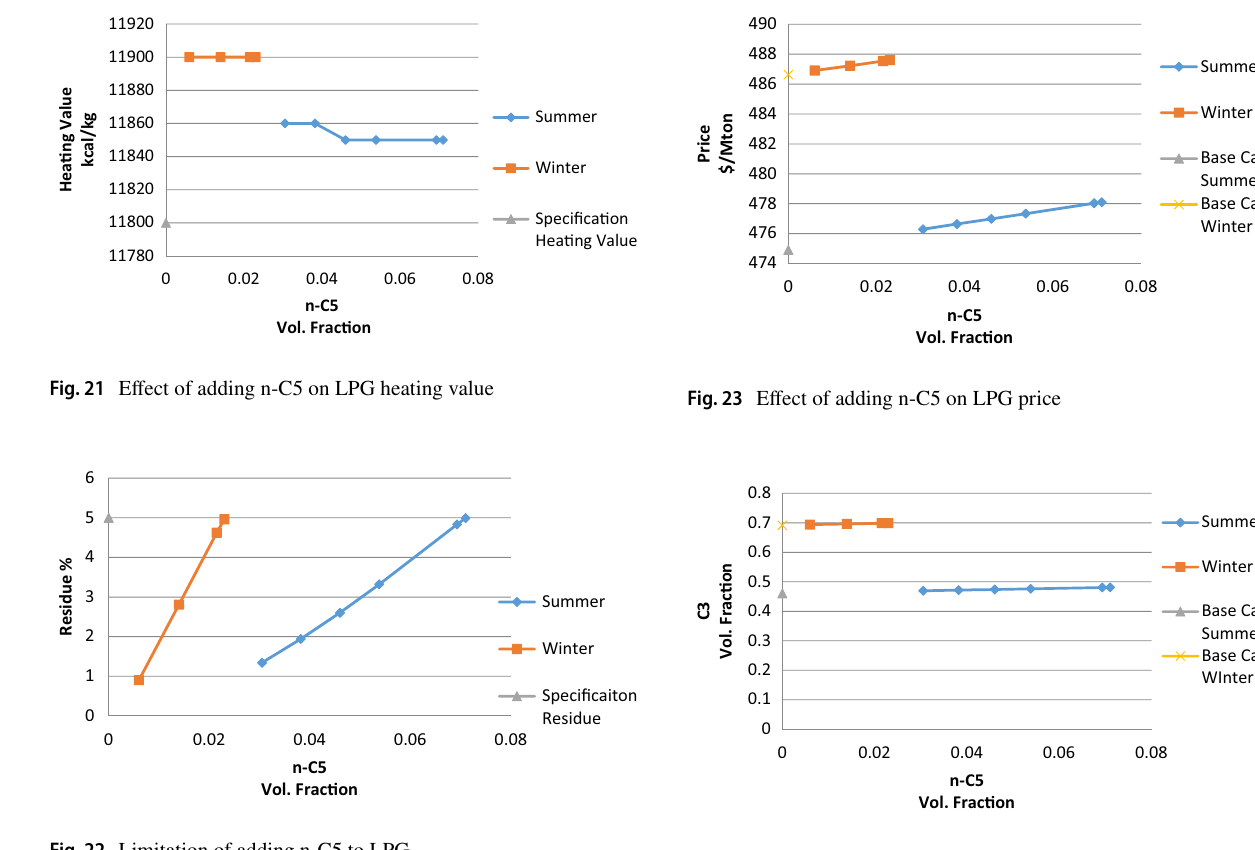
Fig. 24 Effect of adding n-C5 on LPG propane content